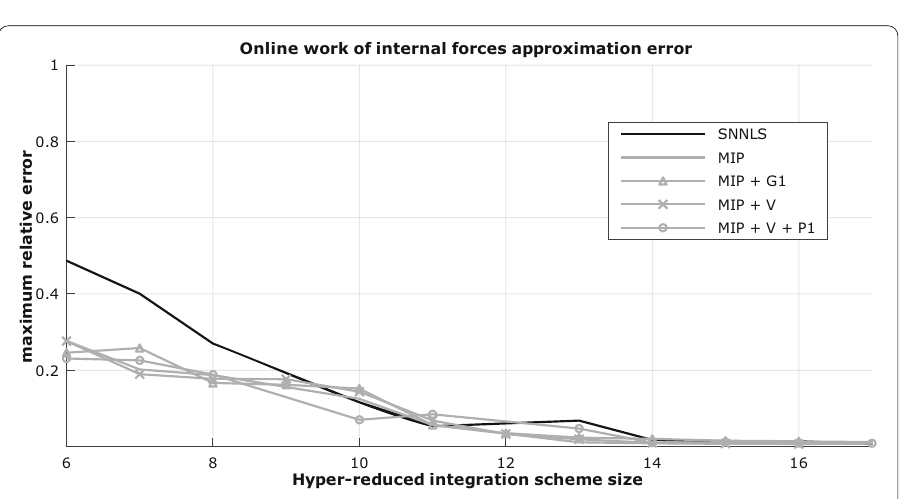
Fig. 5 Online approximation error of the work of internal forces approximation error (35) for SNNLS and proposed methods hyper-reduced integration schemes sizes ranging from 6 to